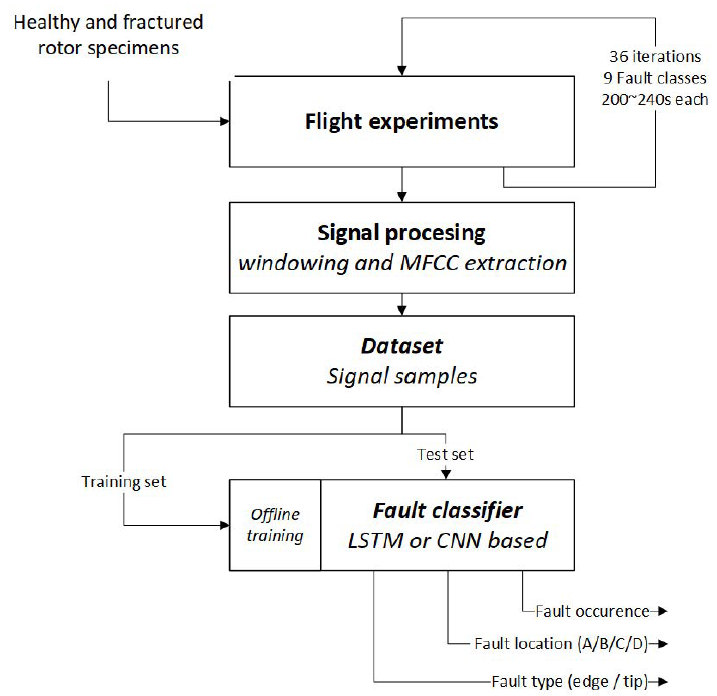
Figure 9. Process of gathering samples of acoustic dataset and evaluating FDI